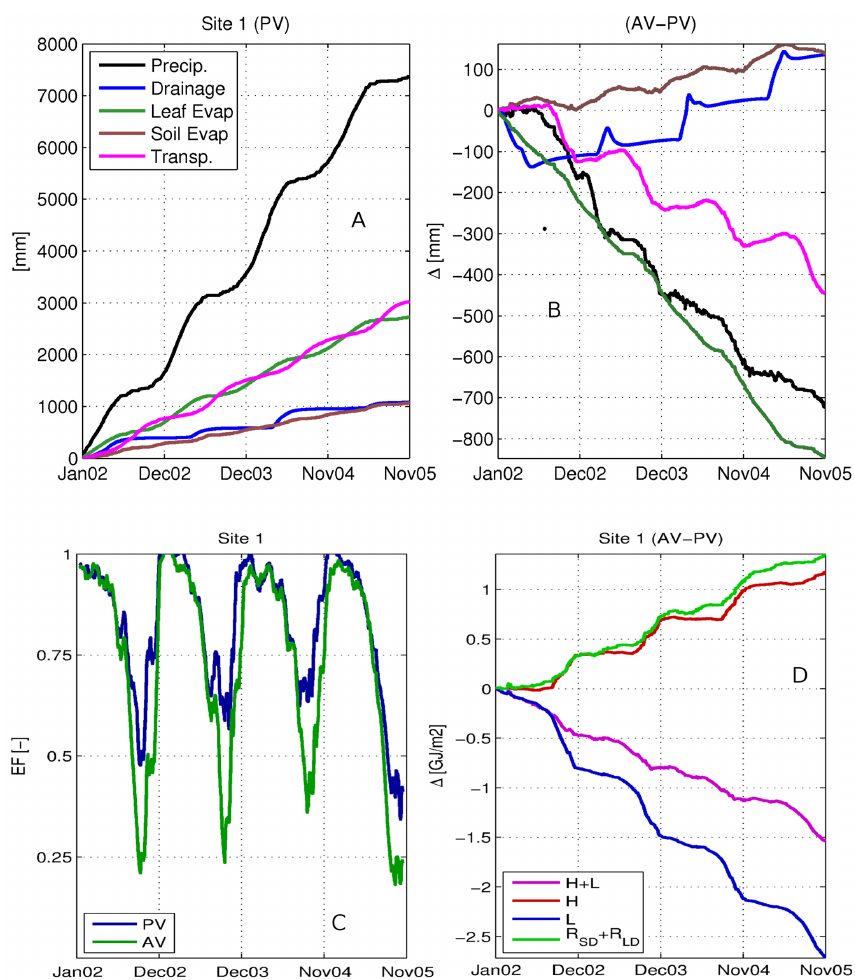
Figure 8. Time series analysis of the surface water and energy balance at the Pará focus site, 2002–2005. (a) Accumulated water flux for the potential scenario. (b) Accumulated differential water flux between the actual (AV) and potential (PV) scenarios. (c) Mean evaporative fraction, latent heat flux ( L ) divided by the sum of latent and sensible ( H ) heat flux ( L /( L + H )). (d) Accumulated differential energy flux in gigajoules per square meter. R SD is downwelling shortwave radiation incident on the surface, R LD is downwelling longwave radiation incident on the